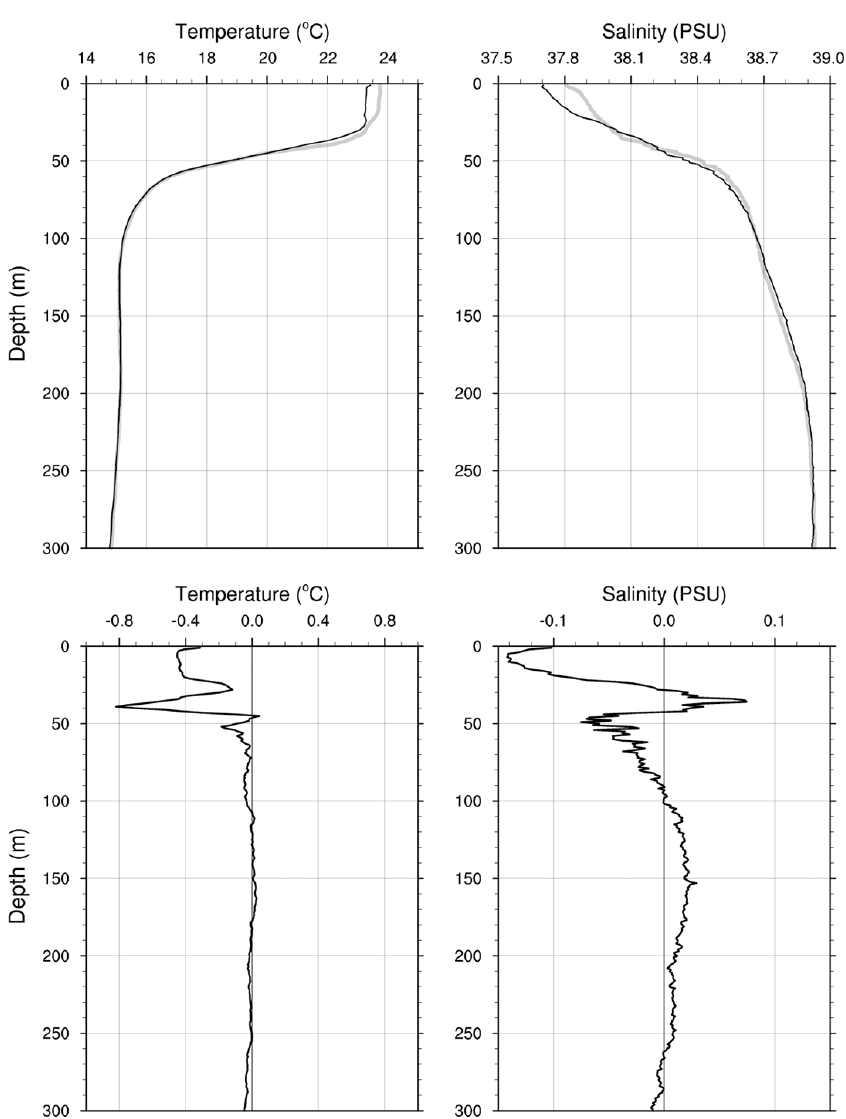
Figure 6. Superimposed mean temperature and salinity LS1 and LS2 profiles and differences. Top left: LS1 (grey line) and LS2 (black line) mean temperature profiles. Top right: LS1 (grey line) and LS2 (black line) mean salinity profiles. Bottom left: LS2–LS1 mean temperature difference. Bottom right: LS2–LS1 mean salinity